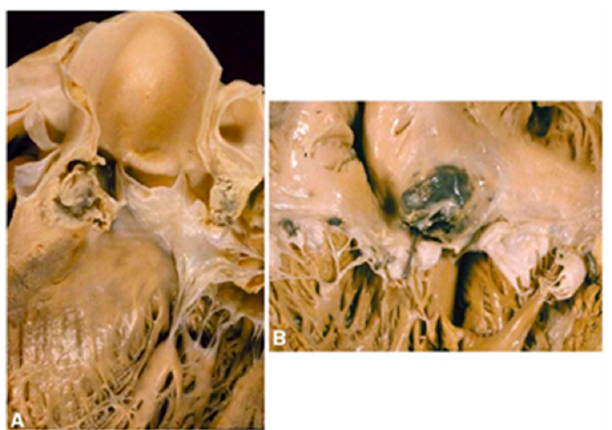
Figure 1. The local spreading of IE infection. IE originates from the aortic valve and can spread to the ventricular wall ( A ) and atrium wall ( B ). Adapted with permission from Thiene and Basso [16]. 2006, Elsevier.